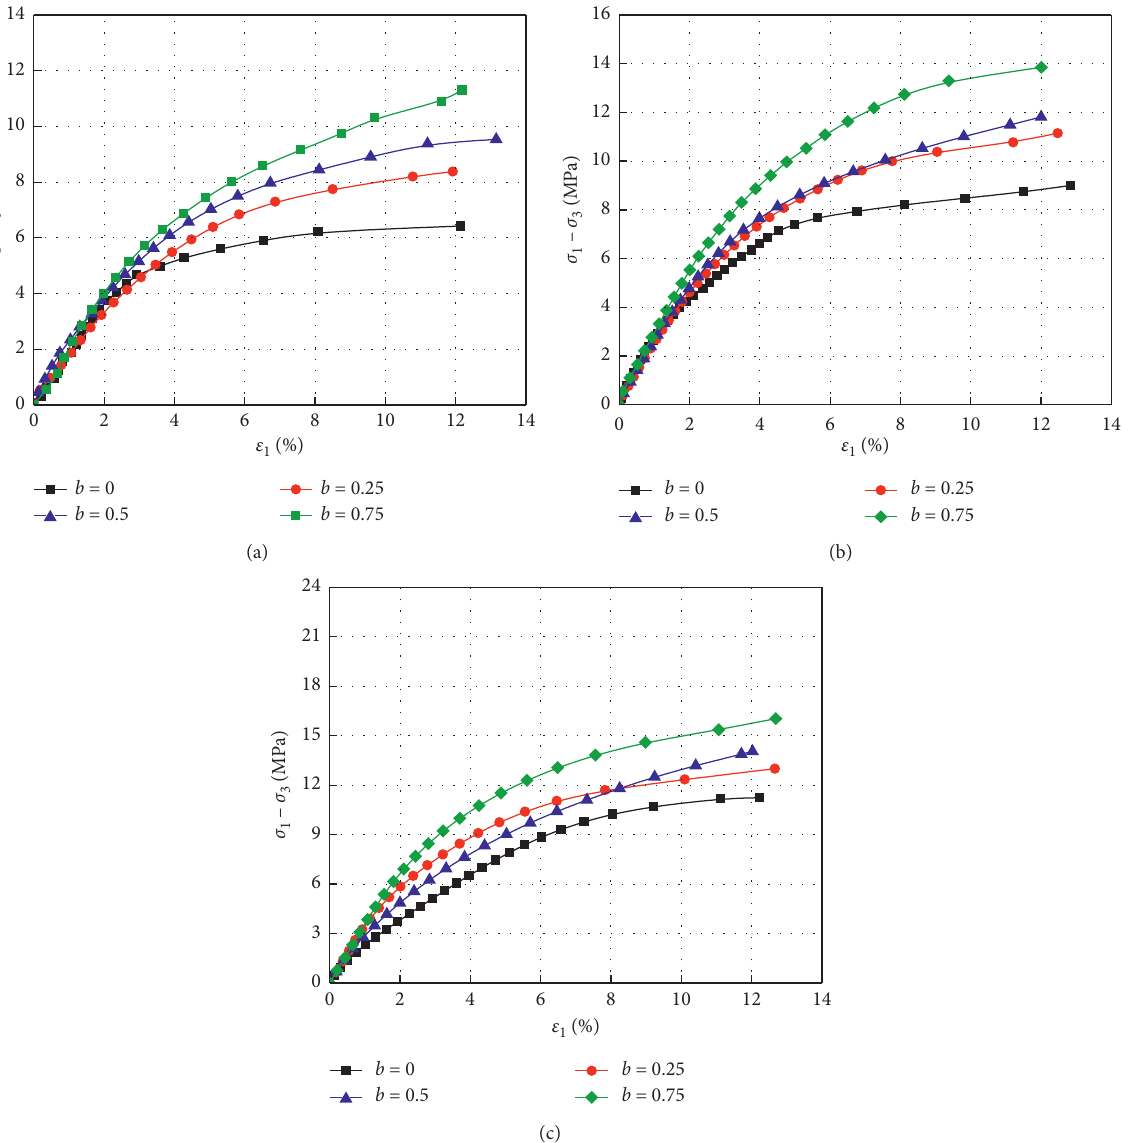
Figure 5: Curves of partial stress and large principal strain of frozen sand at different temperatures. (a) − 5 ° C. (b) − 10 ° C. (c) − 15 °